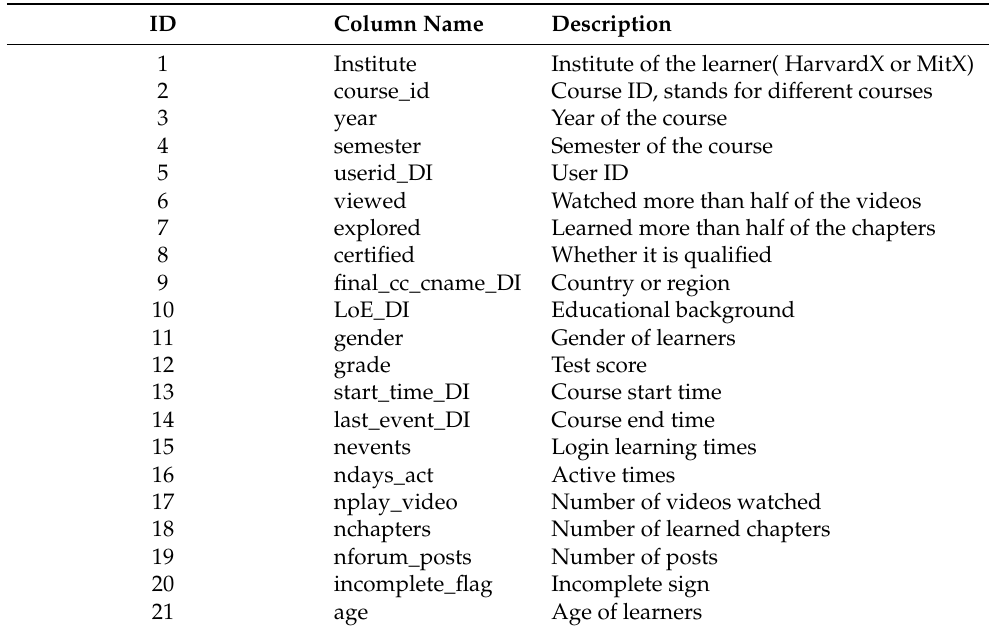
Table 1. Columns in the dataset.